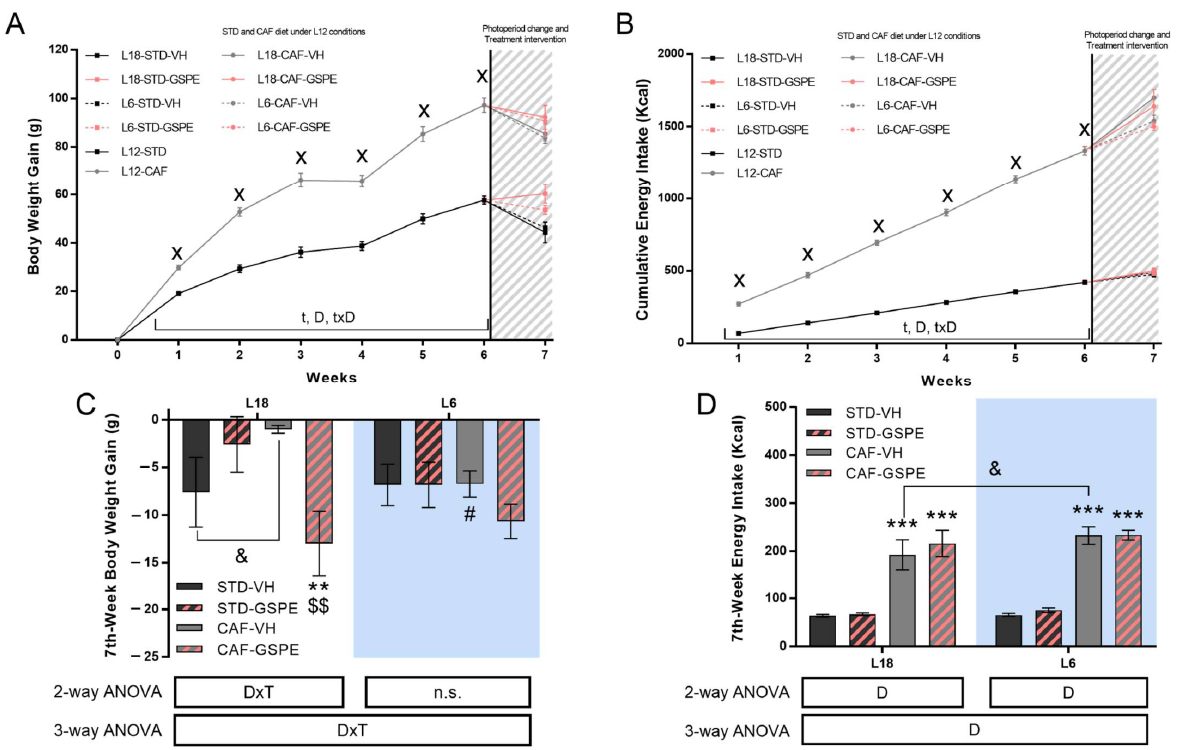
Figure 2. Body weight gain and cumulative food intake. ( A ) Body weight gain and ( B ) Cumulative energy intake over the experiment. ( C ) Body weight gain in the seventh week for L18 and L6 conditions and ( D ) Cumulative energy intake for L18 and L6 conditions (STD-VH, STD-GSPE, CAF-VH, and CAF-GSPE) in the seventh week. Values are expressed as the mean ± S.E.M. ( n = 24 for L12 groups and n = 6 for L18 and L6 groups). x Indicates significant differences using repeated measured-ANOVA followed by a Student’s t -test between L12-STD vs. L12-CAF ( p ≤ 0.001). D, diet effect; DxT, interaction between treatment and Diet; t, time effect; txD, interaction between time and diet effect. n.s., no significant differences. ** or *** Indicate significant differences by diet effect ( p ≤ 0.01 and p ≤ 0.001, respectively), $$ Indicates significant differences by treatment effect ( p ≤ 0.01), # Indicates significant differences by photoperiod effect using 2-way and 3-way ANOVA followed by a LSD post-hoc test ( p ≤ 0.05). & Indicates tendency using a LSD post-hoc test ( p = 0.1–0.051). STD, Standard diet-fed rats; CAF, Cafeteria diet-fed rats; VH, rats administered vehicle; GSPE, rats administered 25 mg/kg grape seed proanthocyanidin-rich extract; L12, standard photoperiod 12 h light per day; L18, long photoperiod 18 h light per day; L6, short photoperiod 6 h light per day. The blue background corresponds to the groups under L6 conditions.